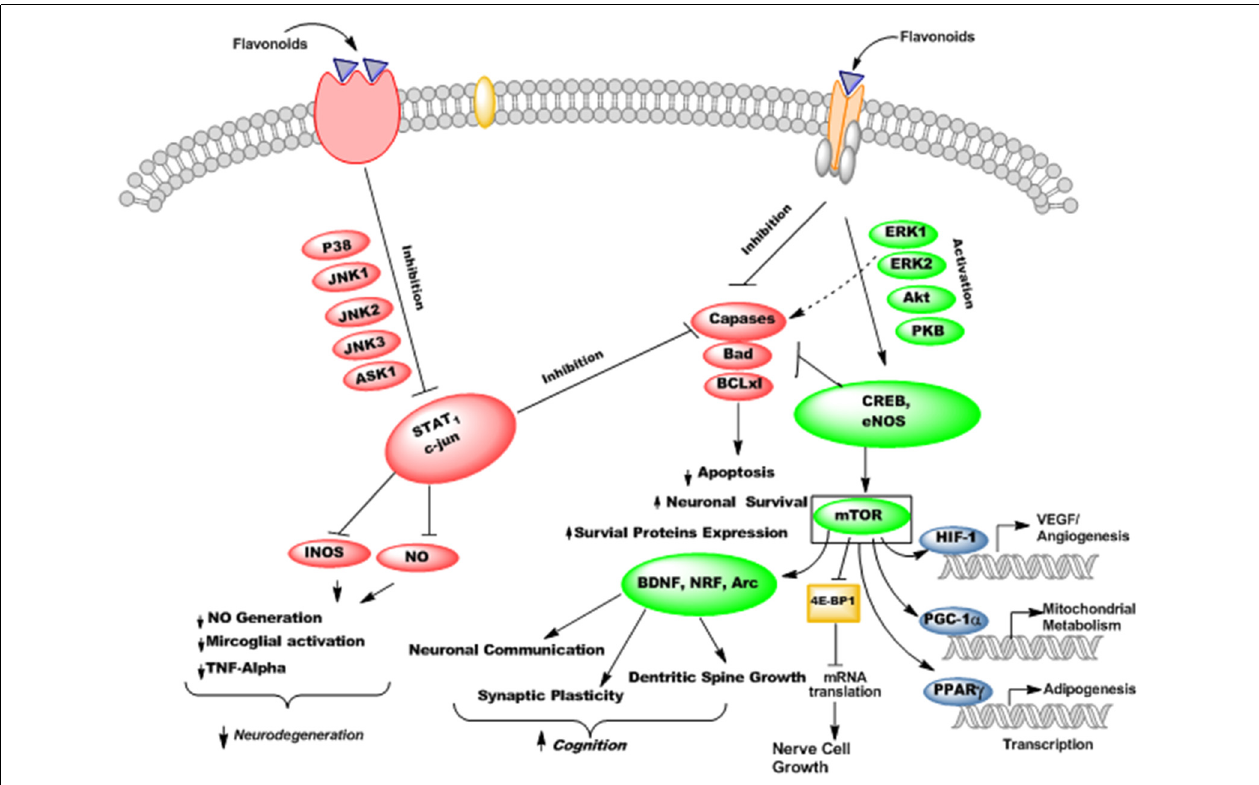
FIGURE 11 | The probable mechanisms of flavonoids stimulating/inhibiting signaling pathways implicated in cognitive performance and neurodegeneration.